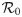
Shown here are the fraction of neighborhood configurations that can be controlled with door-to-door alone as a function of percent compliance, as well as the fraction of configurations that are more cost-effective to be controlled with door-to-door control compared to aerial spraying.Results are shown for three values of the vector hopping rate: Blue, red, and green curves correspond to the hopping rates ω = 5μ0, ω = μ0, and ω = 0.5μ0, respectively. For each value of percent compliance and hopping rate, we average over 200 random neighborhood compliance configurations which are either highly clustered or randomly dispersed, assuming periodic boundary conditions. Solid curves represent the fractions of randomly dispersed configurations that are controllable with door-to-door control (e.g. those where R0 can be brought to unity), and the neighboring dotted curves represent the fractions of randomly dispersed configurations that are both controllable and cost-effective (e.g. those that are both controllable and cheaper to control with door-to-door control than with aerial spray). The dashed curves represent the fractions of highly clustered configurations that are controllable, and the neighboring dashed-dotted curves represent the fractions of highly clustered configurations that are both controllable and cost-effective.